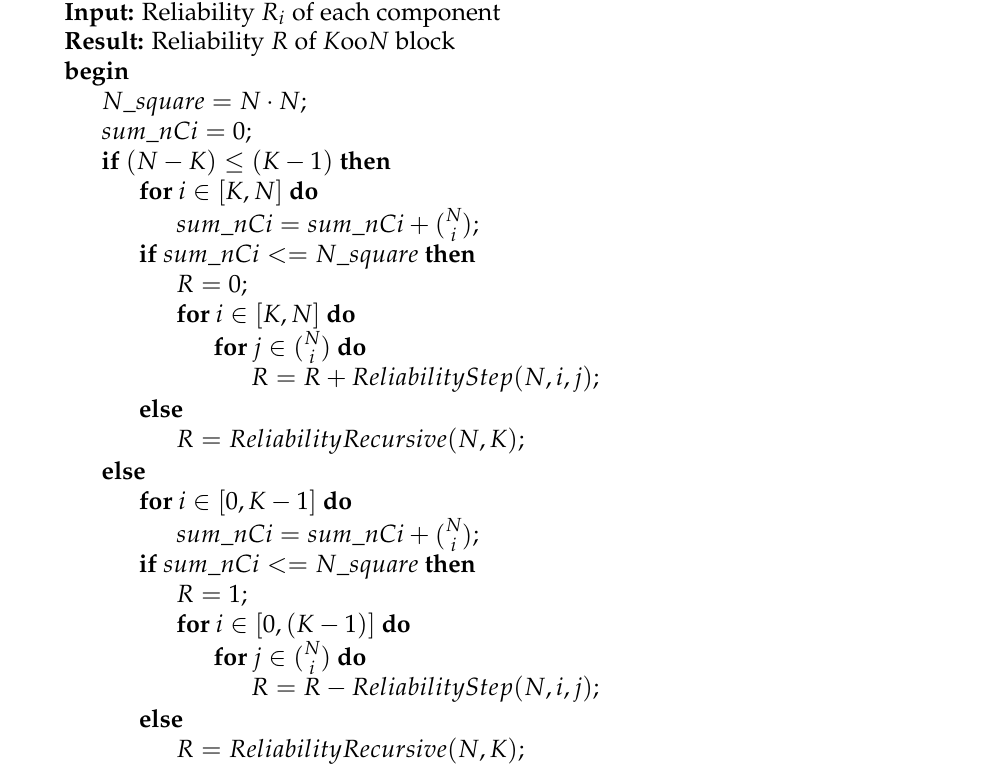
Algorithm 1: Computation of RBD K oo N block with generic